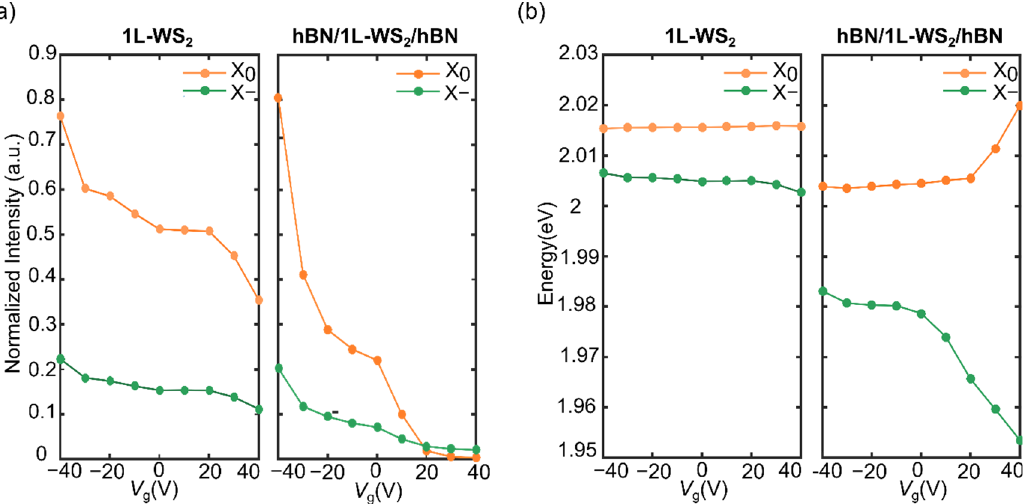
Figure 4. ( a ) Normalised integrated PL intensities of the X and X − peaks versus gate voltage on the 1LWS 2 (left panel) and the hBN/WS 2 /hBN region (right panel). ( b ) Emission energy peaks of X and X − versus gate voltage on the 1L-WS 2 (left panel) and the hBN/WS 2 /hBN region (right panel).